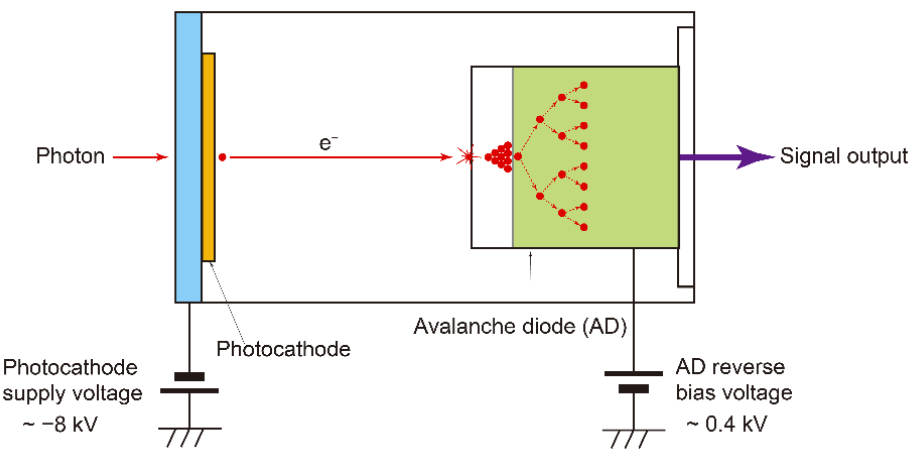
Figure 6. Schematic of a hybrid photodetector (HPD).